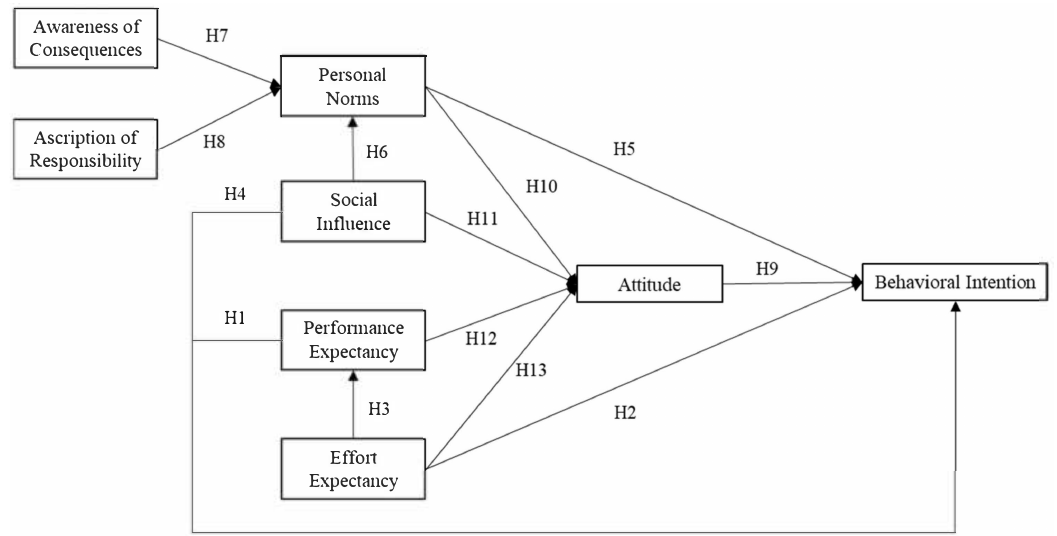
Figure 1. The proposed theoretical